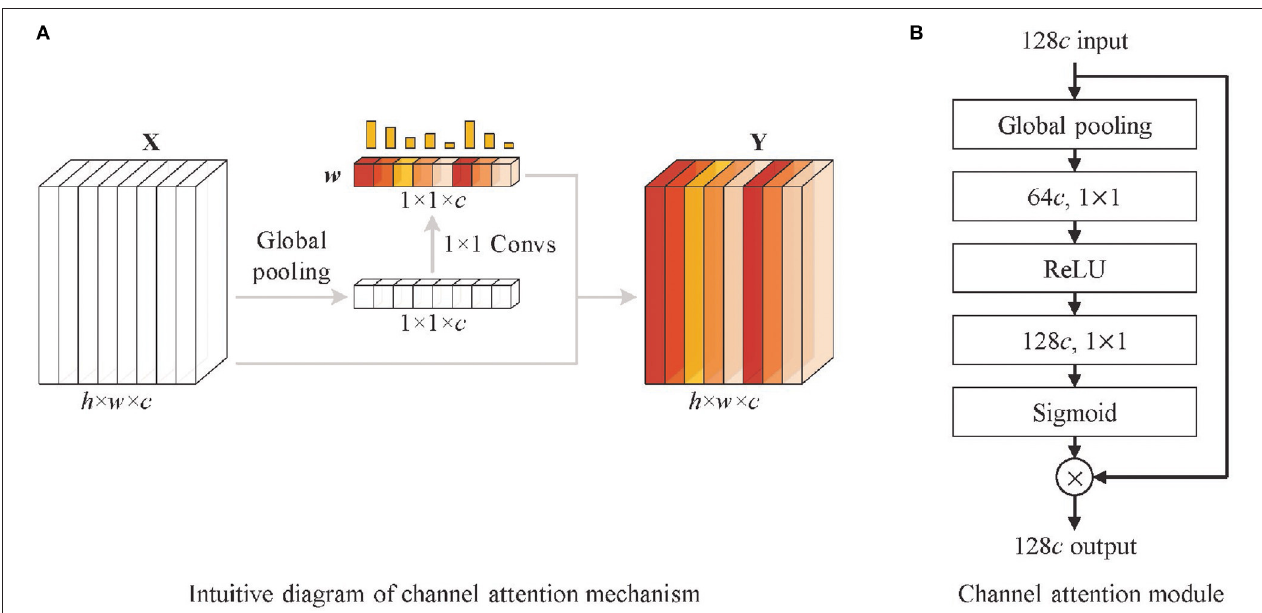
FIGURE 4 | Structure of channel attention module. (A) The intuitive diagram of the channel attention mechanism and (B) channel attention module. It firstly performs global pooling to the input feature map (128c denotes 128 channels) to obtain the overall representations. Then a weight vector is learned by 1 × 1 convolution operations. The learned weight vector allocates weight coefficients for each channel of the original feature map, and the weighted feature map is